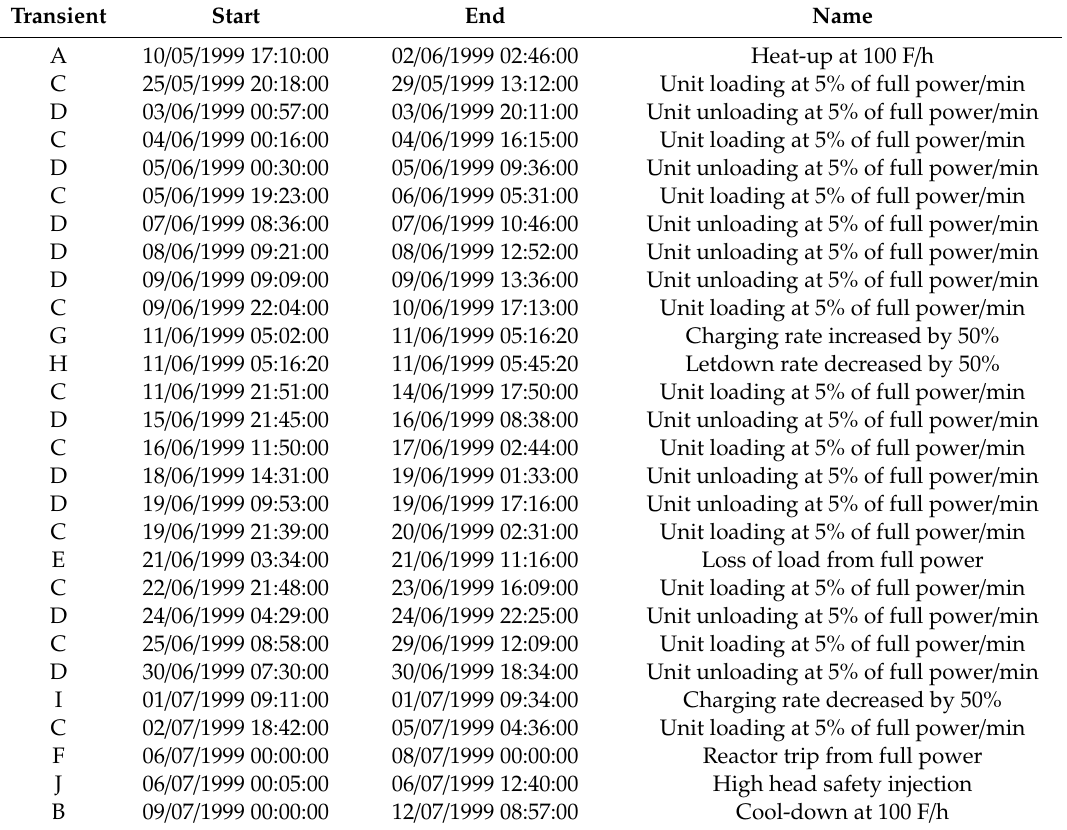
Table 2. Transients of the second sequence. Dates do not necessarily correspond to actual dates, but the sequence itself, the distribution over time, and the duration of transients correspond to real data. Transient